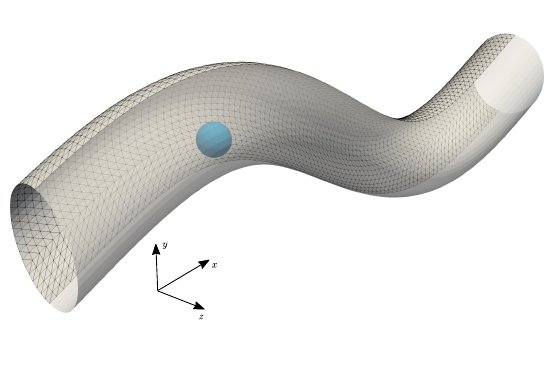
Figure 23. STL triangulation of the pipe wall used in the simulations.